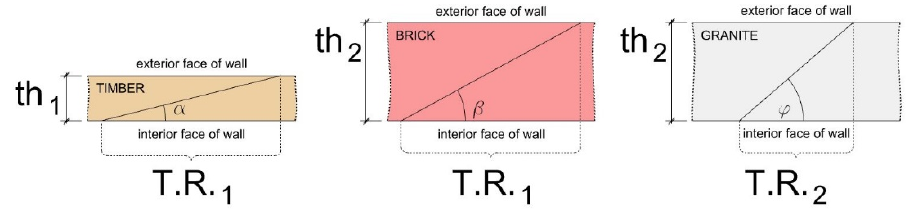
Figure 7. Thickness, thermal resistance, and the angle tangents. Own Source. Table 2. These are the numerical examples for each situation. Table 2. These are the numerical examples for each situation. First Case Second First Case Second Case